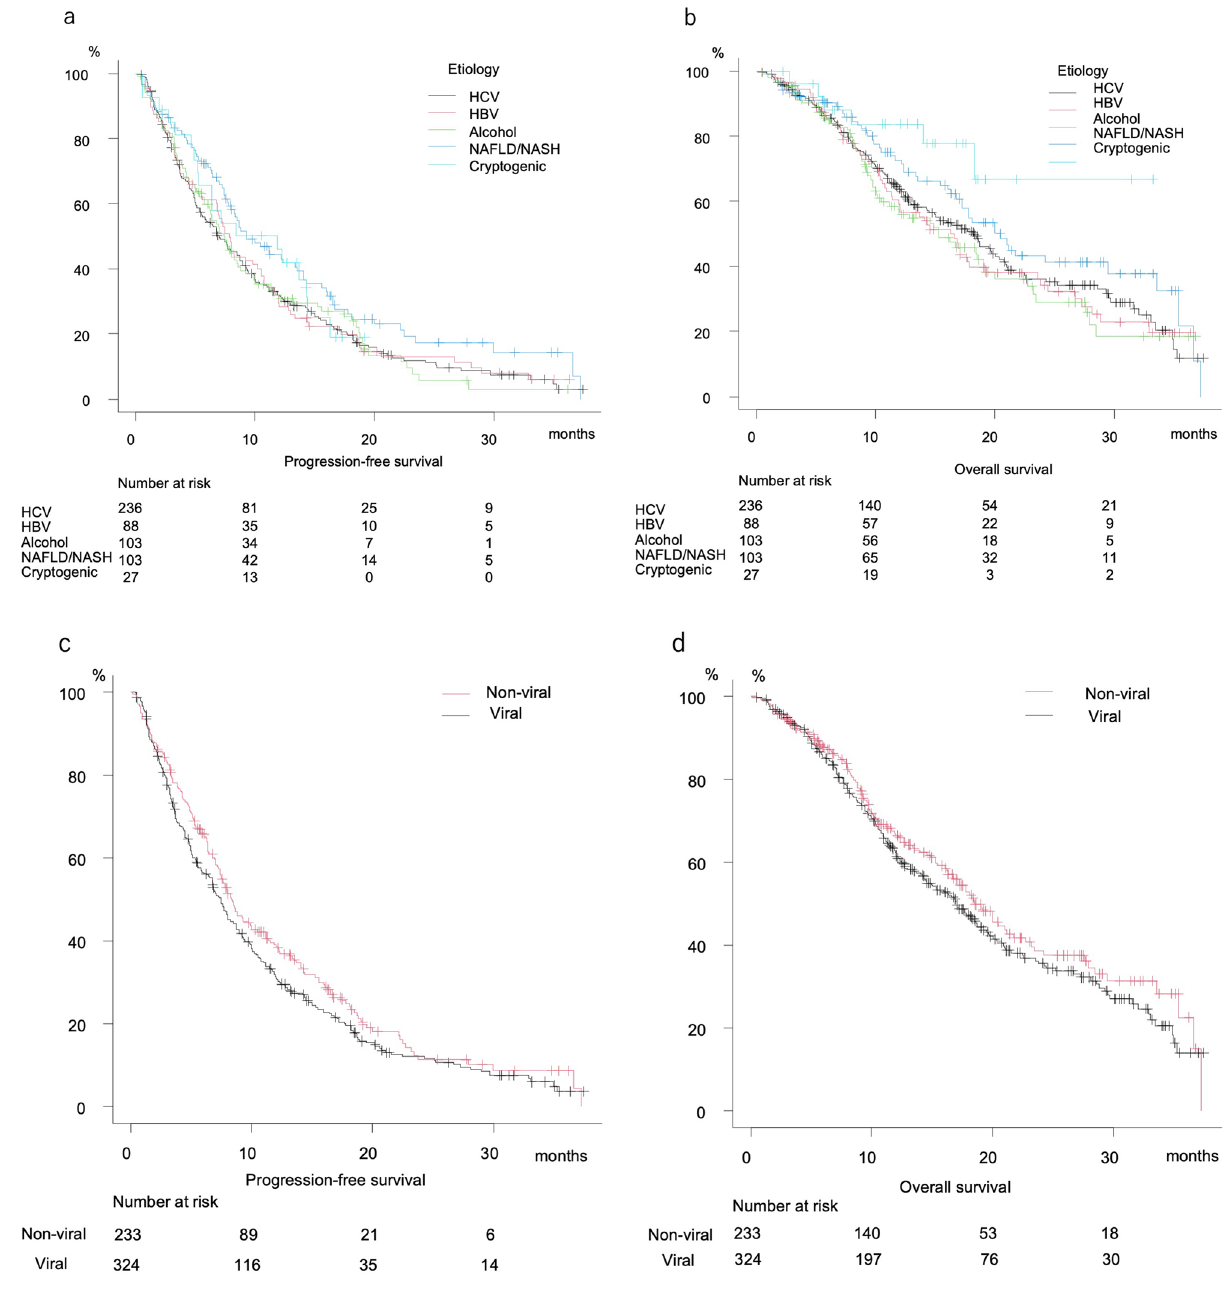
Figure 4. Progression-free and overall survival according to basal liver disease etiology. ( a ) Progression-free survival divided by basal liver disease etiology. HCV (median 7.0 months, 95% CI 5.5–8.7), HBV (median 7.9 months, 95% CI 6.8–10.5), alcohol (median 7.4 months, 95% CI 5.8–8.6), NAFLD/NASH (median 9.3 months, 95% CI 7.8–13.5), cryptogenic (median 11.9 months, 95% CI 5.2–14.4) (P = 0.154). ( b ) Overall survival divided by basal liver disease etiology. HCV (median 18.3 months, 95% CI 14.3–20.4), HBV (median 16.3 months, 95% CI 11.4–19.3), alcohol (median 15.3 months, 95% CI 10.5–19.2), NAFLD/NASH (median 20.5 months, 95% CI 16.8–29.5), cryptogenic (median not reached, 95% CI 18.3-not reached) (P = 0.052). ( c ) Progression-free survival of Viral and Non-viral (NAFLD/NASH, Cryptogenic, Alcohol) groups. Viral (median 7.5 months, 95% CI 6.4–8.5), Non-viral (median 8.3 months, 95% CI 7.4–10.0) (P = 0.092). ( d ) Overall survival of Viral and Non-viral (NAFLD/NASH, Cryptogenic, Alcohol) groups. Viral (median 17.2 months, 95% CI 14.4–19.3), Non-viral (median 18.5 months, 95% CI 16.3–21.7) (P = 0.226). ( e ) Progression-free survival of Viral/Alcohol and NAFLD/NASH/Cryptogenic groups. Viral/Alcohol (median 7.5 months, 95% CI 6.8–8.0), NAFLD/NASH/Cryptogenic (median 9.3, 95% CI 7.8–13.4) (P = 0.012). ( f ) Overall survival of Viral/Alcohol and NAFLD/NASH/Cryptogenic groups. Viral/Alcohol (median 16.9 months, 95% CI 14.5–18.6), NAFLD/ NASH/Cryptogenic (median 21.0 months, 95% CI 17.8–33.5) (P =